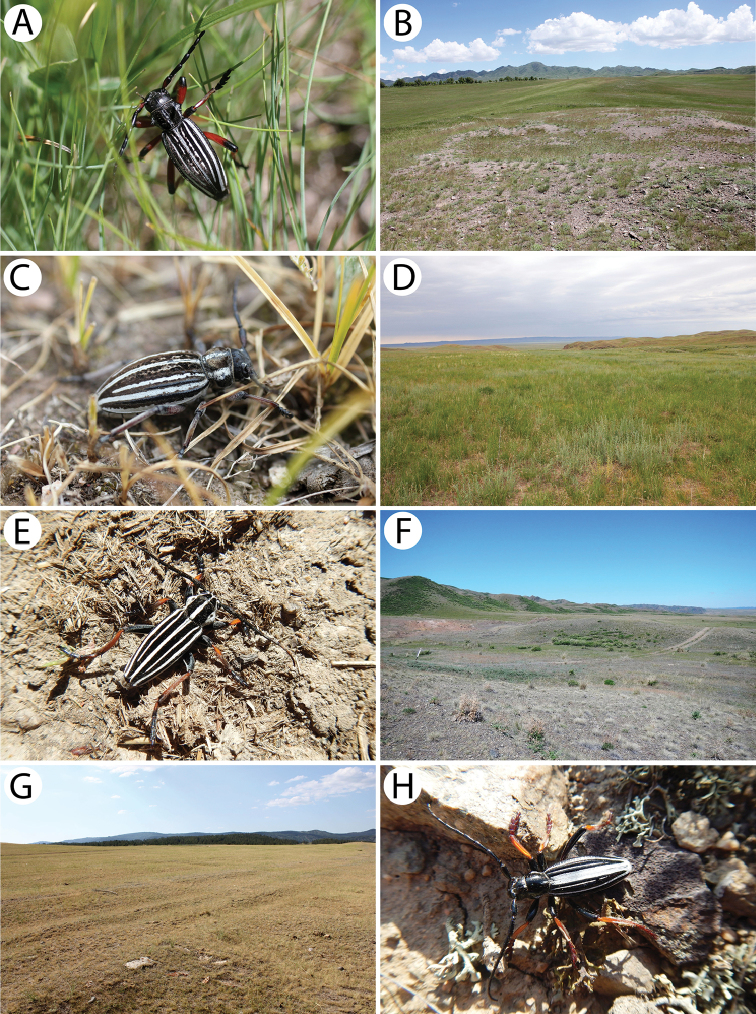
Field photos of imagines in nature and habitats of typical Kazakh cerambycid species: A female of DorcadionsuvorovikonyrolenumB steppe area in Karlygash environs, the habitat of D.suvorovikonyrolenumC female of DorcadiontianshanskiiradkevitshiD pasture in Kenen environs, the habitat of D.tianshanskiiradkevitshiE male of DorcadionunidiscaleF mountain steppe area in Kyzyl Kesik environs, the habitat of DorcadionsongaricumG pasture in Verkhnie Tainty environs, the habitat of EodorcadioncarinatumcarinatumH male of Politodorcadionpolitumpolitum.